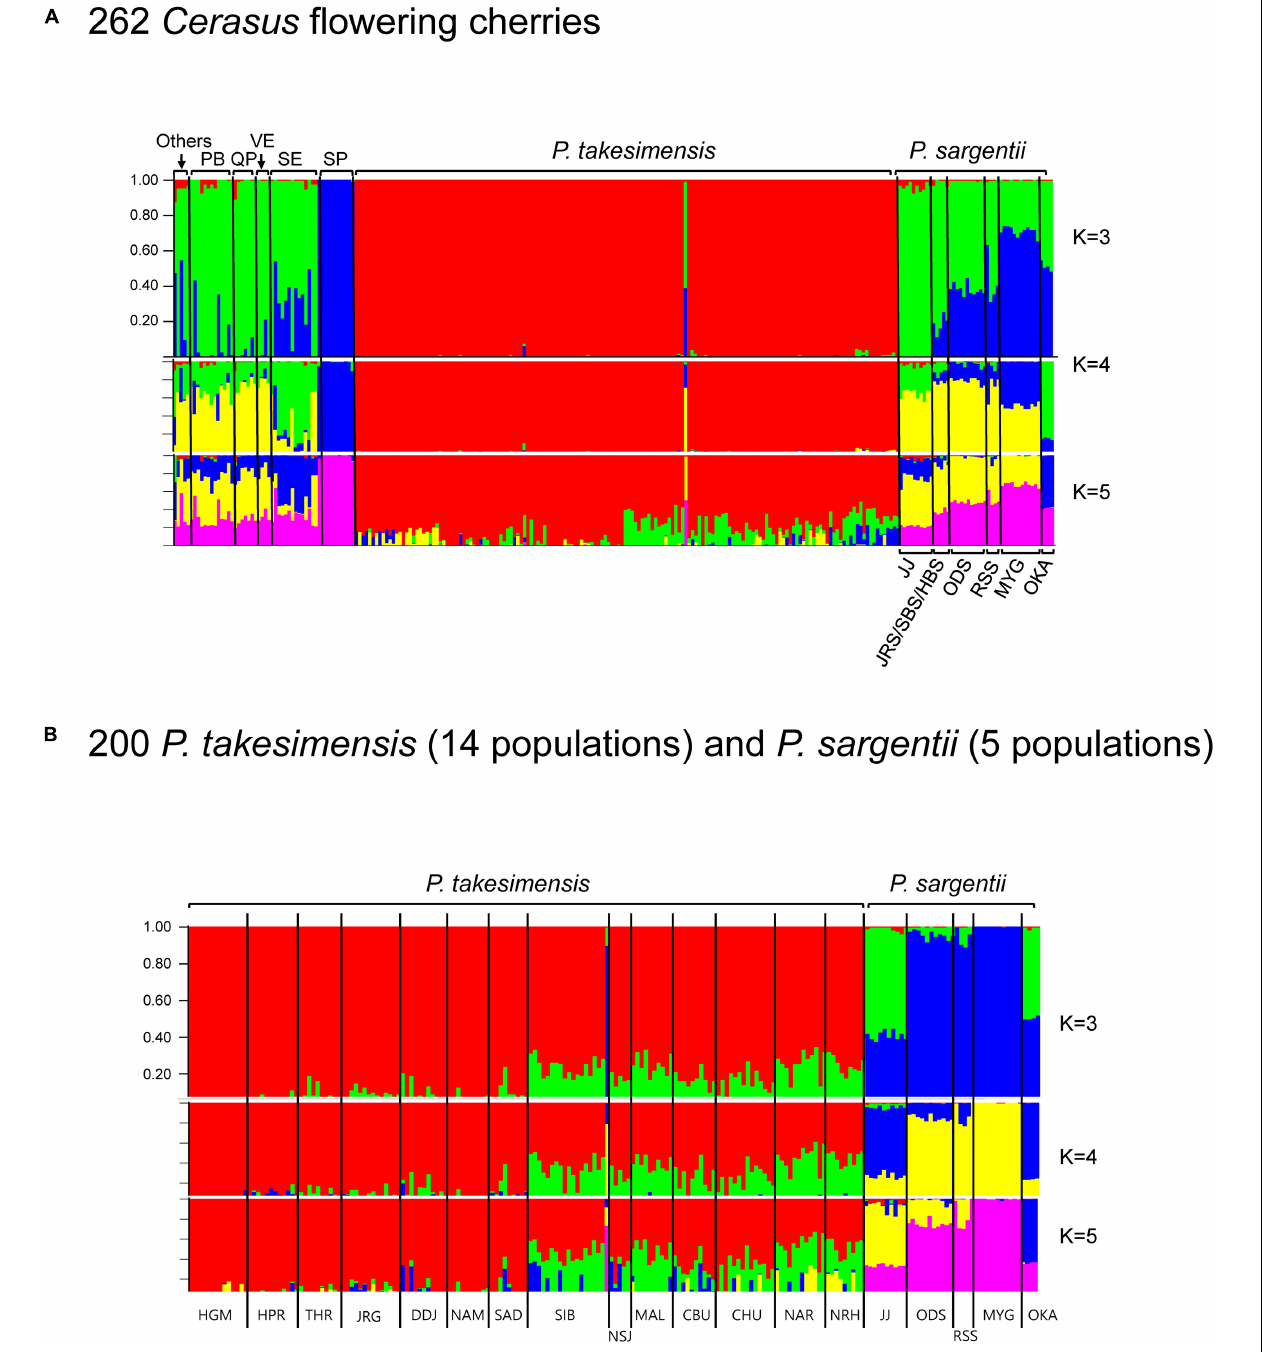
FIGURE 6 | Population genetic structure by Bayesian clustering using STRUCTURE based on MIG-seq SNPs. Bar plots illustrate the population structure at K = 3, 4, and 5 in 262 Cerasus flowering cherries (A) , and 200 of P. takesimensis (14 populations) and P. sargentii (5 populations) (B) . Each individual is represented by a single vertical line composed of K colored segments, with lengths proportional to estimated membership percentage of the K clusters, respectively. Bar plot for best K value ( K = 3 for both 262 and 200 datasets) determined by STRUCTURE HARVESTER is depicted larger than the bar plots of other Ks. Species name abbreviations: PB for P. serrulata var. pubescens , QP for P. serrulata var. quelpaertensis , VE for P. sargentii var. verecunda , SE for P. serrulata var. spontanea , and SP for P. speciosa . “ Others” includes the species of P. yedoensis var. angustipetala , P . avium , P. longistylus , P. hallasanensis , and P. maximowiczii. For population